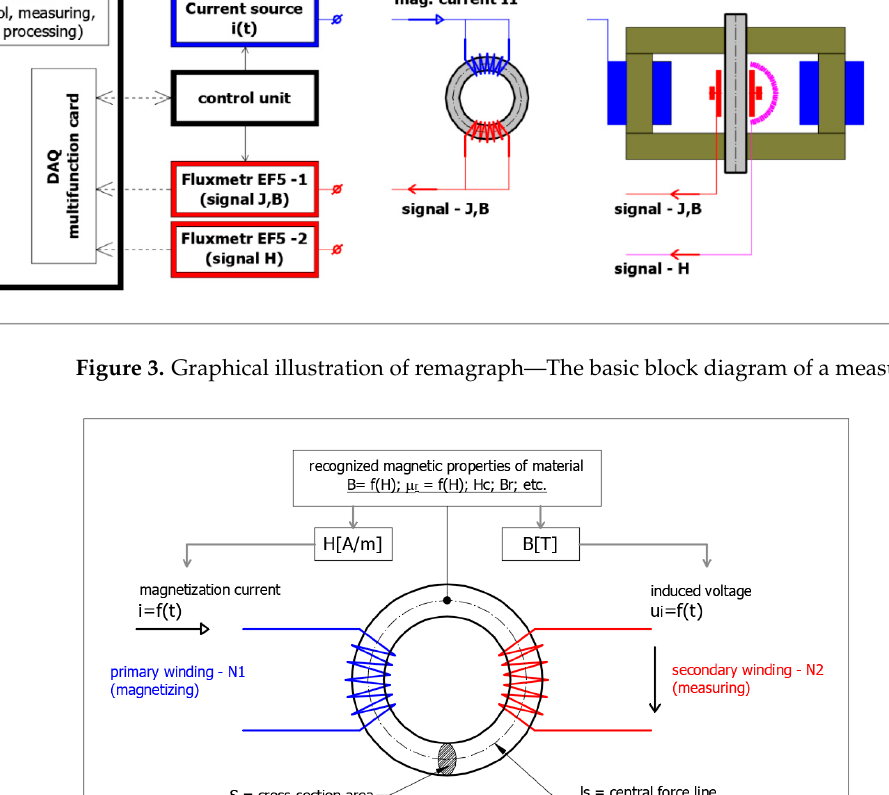
Figure 4. The illustration of the principle of determination of magnetic quantities using toroidal samples.